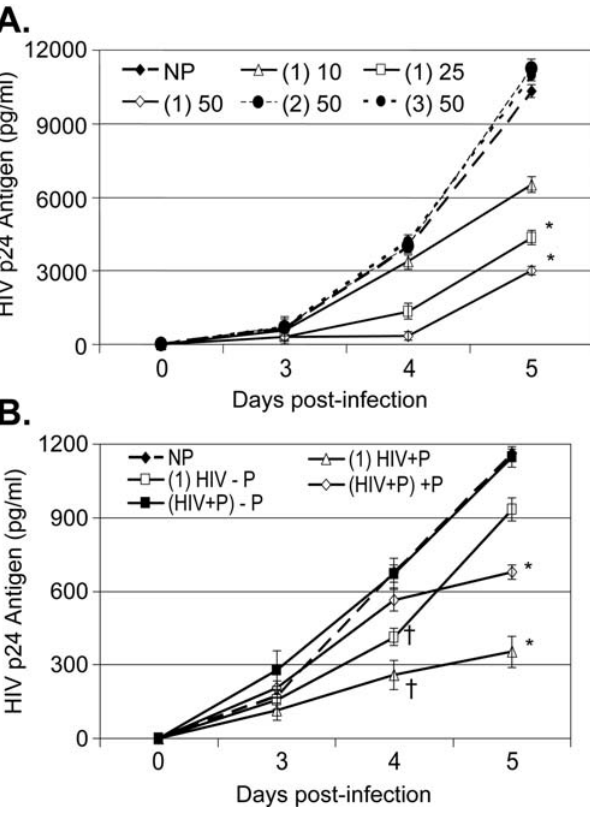
Figure 8. GBV-C NS5A synthetic peptides inhibit HIV replica- tion. Addition of a synthetic peptide representing GBV-C NS5A amino acids 152–191 (P1) to MT-2 cells 1 hour before HIV infection resulted in a dose-dependent inhibition of HIV replication (concentration of peptide=10, 25, or 50 m g/ml; panel A). By comparison, overlapping peptides including GBV-C NS5A amino acids 172 to 211 (P2) or amino acids 197 to 236 (P3) did not inhibit HIV replication at 50 m g/mL. All HIV replication was compared to cells incubated with no peptide (NP). Addition of peptide 1 (amino acids 152–191) to Jurkat cells 24 hrs prior to HIV infection [(1) HIV] resulted in inhibition of HIV on day 4 ( { p , 0.05; panel B). In cells in which peptide was not included after HIV infection ( 2 P), HIV inhibition was lost on day 5. When HIV and the peptides were added to cells simultaneously (HIV + P), inhibition was not observed on day 4; however, when the peptide was included in the media ( + P), HIV replication was inhibited by day 5 (* p , 0.05 compared to the NP